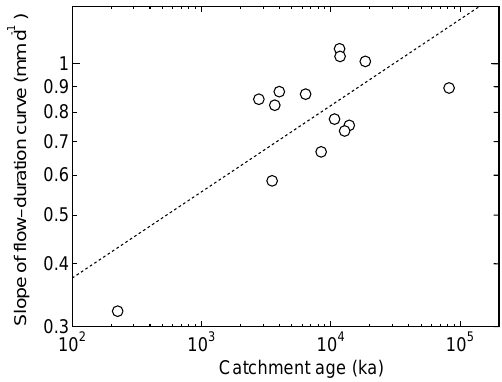
Figure 4. Relation between aridity index and age for the study catchments.